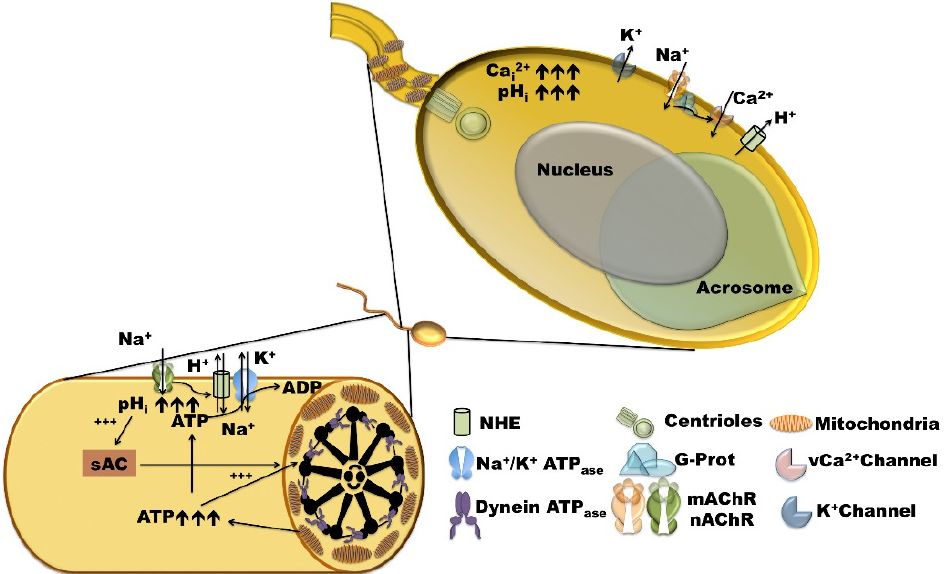
Figure 1. Main mechanisms involved in sperm capacitation and motility activation. The regulation of pH i and Ca i2+ levels within the sperm depends on the activity of NHE, voltage activated Ca 2+ channels, Na + /K + -ATPase and the ATP availability regulated by oxygen tension in the media. NHE: Na + -H + exchanger; AChR: nicotine acetylcholine receptors; sAC: soluble adenyl cyclase. Detailed description included in the text.